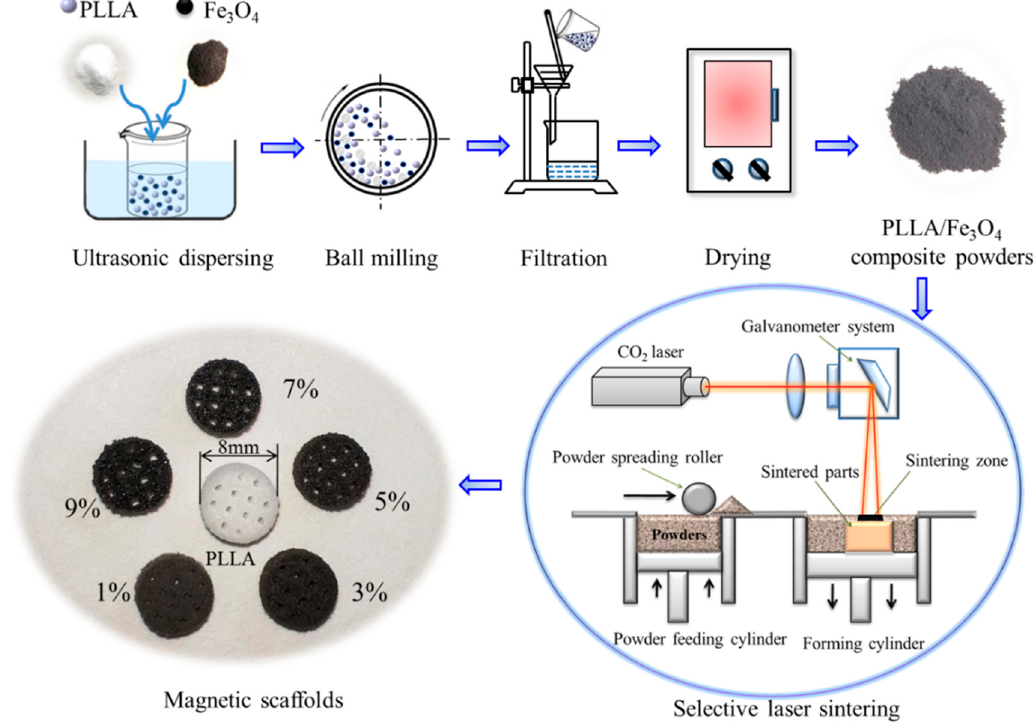
Figure 1. A schematic of the preparation of PLLA/Fe 3 O 4 magnetic composite scaffolds.